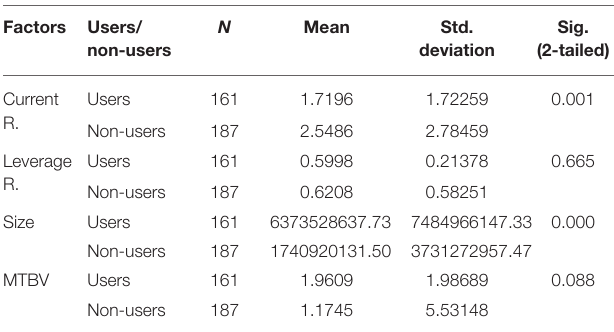
TABLE 9 | The results of the T -test analysis of the companies. Factors Users/ non-users